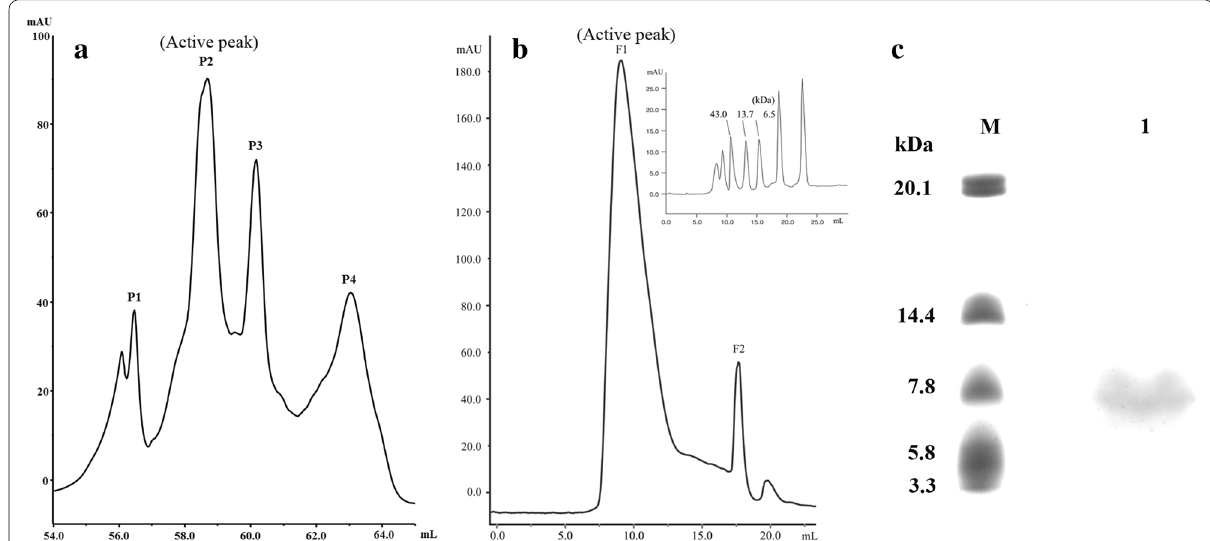
Fig. 1 The purification of the new elicitor protein. a The anion exchange chromatography map. P1-P4 were peaks eluted with a linear gradient of NaCl. b The superdex chromatography map. F1 and F2 were peaks eluted with 20 mM Tris–HCl. Inset, typical chromatogram from a function test of